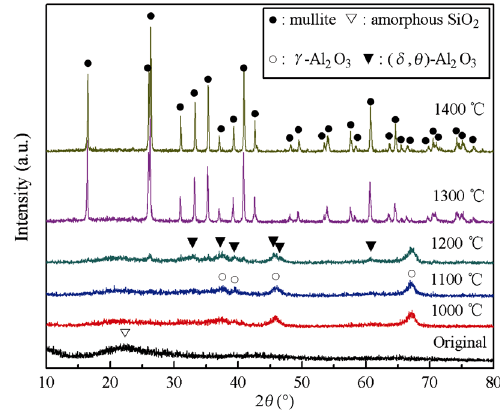
Fig. 1 XRD patterns of gel powders after heat treatment at different